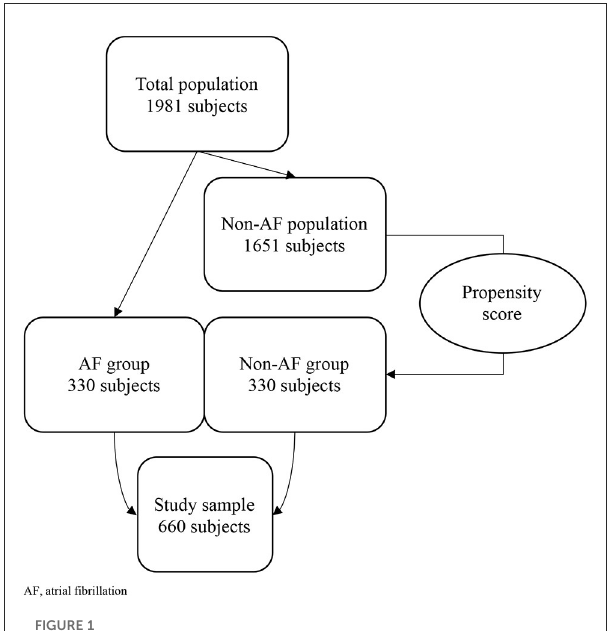
FIGURE1 Study population. AF, atrial